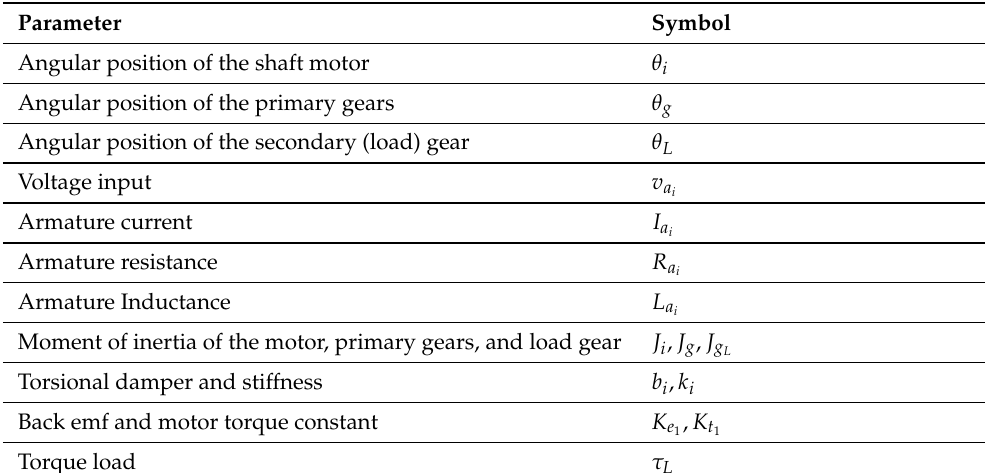
Table 1. Definition of symbols used in